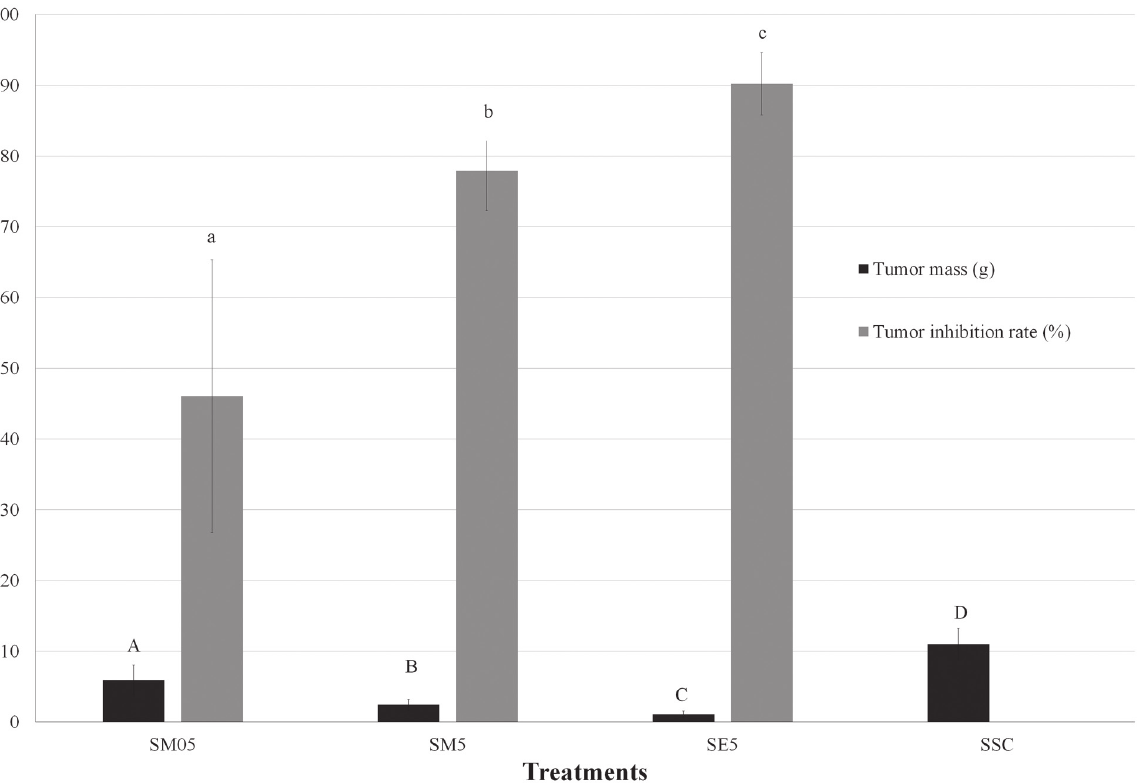
Figure 2 - Inhibition of sarcoma 180 tumor mass implanted in female Swiss mice according to treatments (Table I). Different letters show that the treatments statistically and significantly differed from each other according to Scott-Knott’s test (P ≤